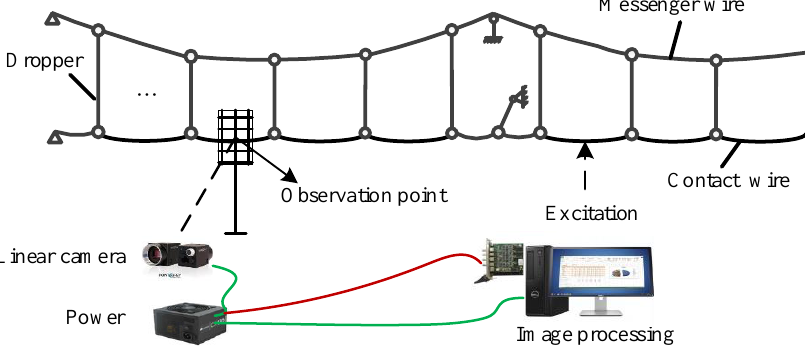
Figure 3. Structural schematic of the non-contact measurement devices employed for catenary vibration.